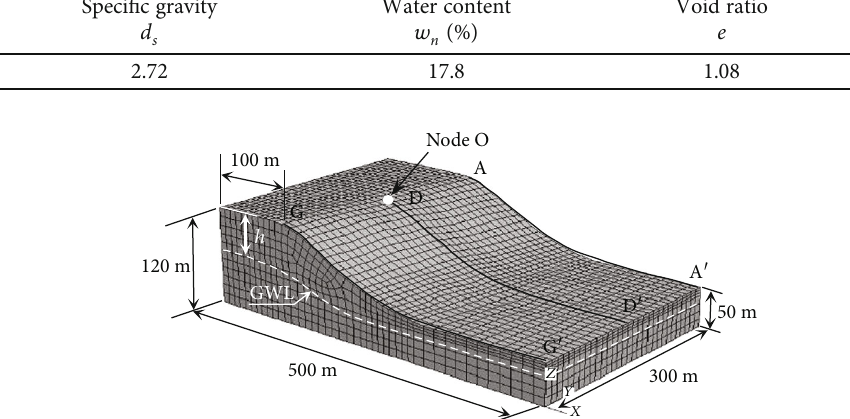
Figure 9: Meshing model of slope before landslide event.